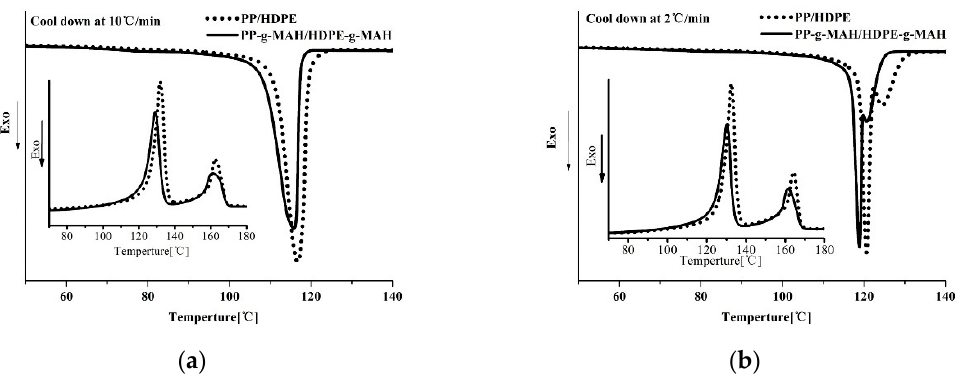
Figure 5. DSC thermograms of PP/HDPE blend and PP- g -MAH/HDPE- g -MAH blend at different cooling and subsequent heating rates: ( a ) 10 °C /min; ( b ) 2°C /min.